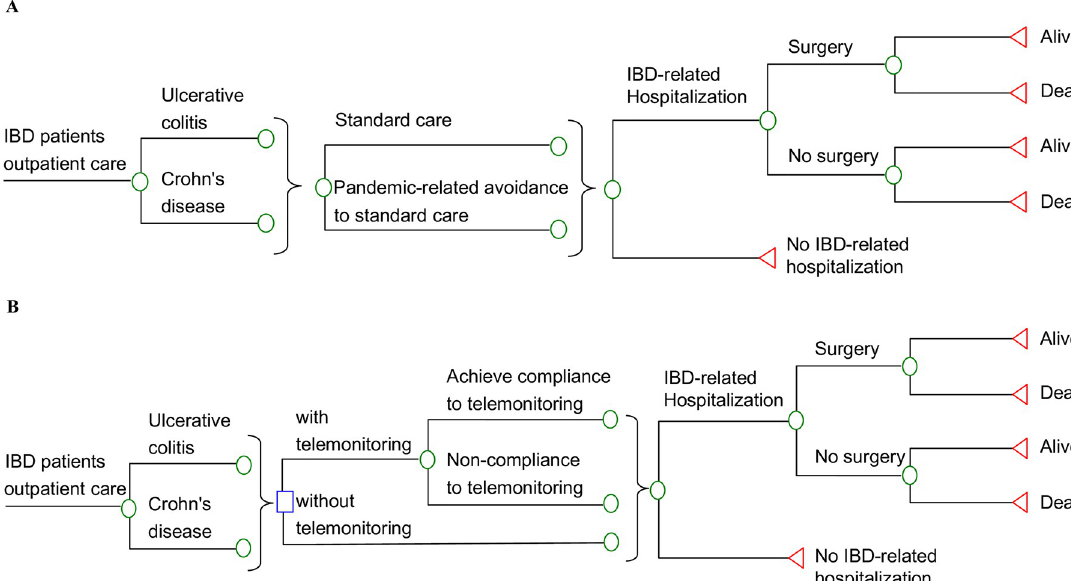
Fig 1. A. Simplified decision-analytic models for standard IBD care with and without pandemic-related avoidance. B. Simplified decision-analytic models for standard IBD care with and without telemonitoring during the pandemic. IBD, inflammatory bowel